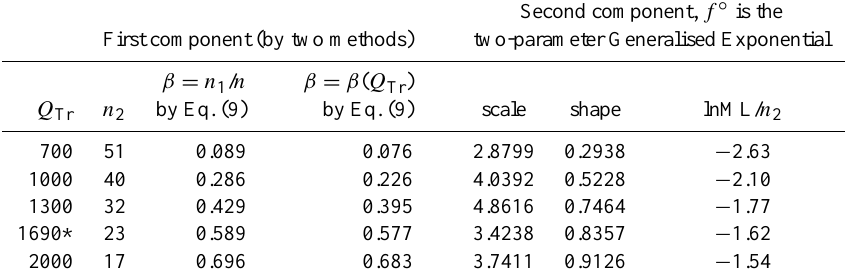
Table 2. The parameters of the two-component DqF model for Szczucin data.